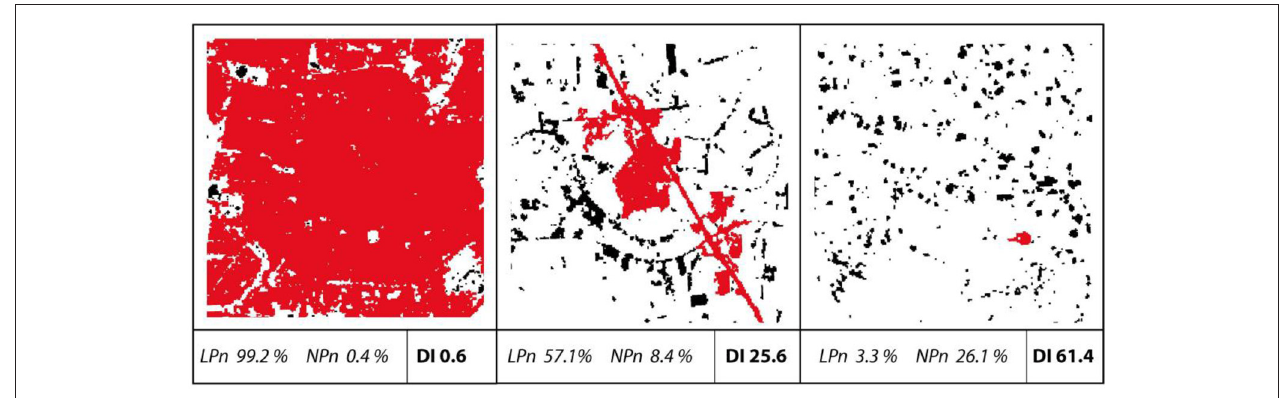
FIGURE 1 | Examples of land use pattern and the related indicators (urbanized land in black, largest patch in red) (Gerten et al.,